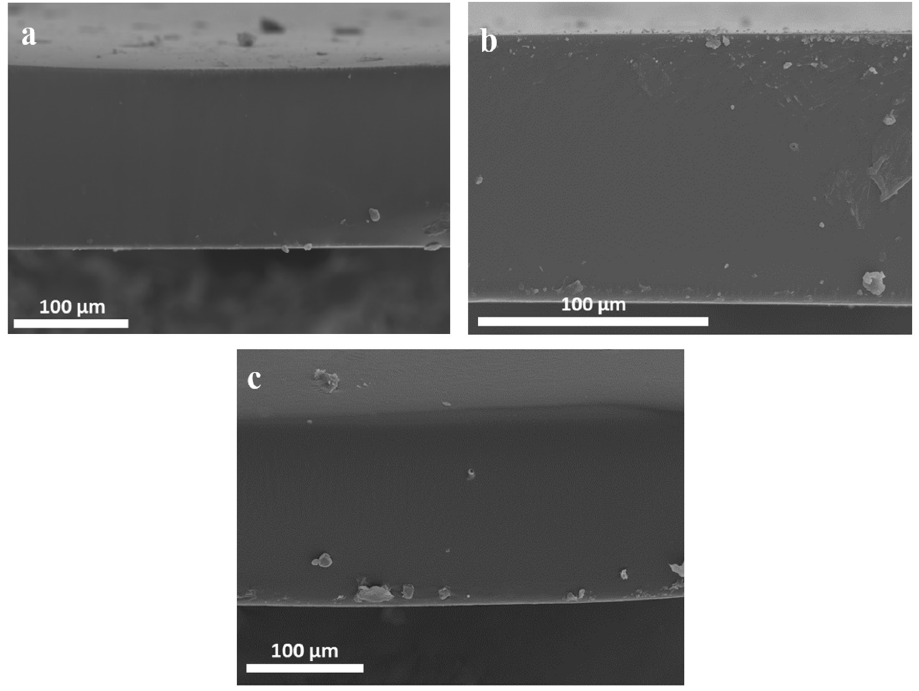
Figure 5. SEM micrographs of composite membranes containing 40 wt%. ( a ) [EMIM][TFSI], ( b ) [EMIM][C(CN) 3 ] and ( c ) [HMIM][TFSI]. 3.2. Gas Separation Properties of Polymer-IL Composite Membranes The gas separation properties of the 2,6Py-PEO 350 precursor copolymer and the com- posite membranes were determined using the Wicke–Kallenbach method at 30 °C. The gas permeability data (CO 2 , CH 4 , H 2 ) are shown in Table 1. It was observed that the pre- cursor copolymer exhibits much lower gas permeability than composite membranes con- taining the imidazolium-based ILs with TFSI - (IL1 and IL3). Generally, IL molecules plas- ticize the polymer matrix, leading to improved chain mobility and increased free volume, and consequently to enhanced gas diffusivity and permeability [18,41–44]. However, sol- ubility also plays a significant role in permeability according to the solubility-diffusion mechanism for dense membranes [45]. For instance, ILs with TFSI - and C(CN) 3- as counter anions are reported to show high CO 2 solubility due to chemical interactions of CO 2 mol- ecules with the anions [46–48]. In addition, the higher fractional free volume of ILs com- pared to polymers facilitates the CO 2 diffusion across composite membranes [38]. In con- trast to this, CH 4 and H 2 have no significant interactions with ILs [38], thus very small additional solubility contribution is expected for CH 4 and H 2 in composite membranes, and, therefore, diffusion mainly contributes to CH 4 and H 2 permeability increases. As a result, the permeability increment is more significant for CO 2 instead of H 2 and CH 4 due to the high diffusivity and solubility of CO 2 in a polymer and IL matrix, respectively. For this reason, CO 2 /CH 4 and CO 2 /H 2 ideal selectivities are also increased with the addition of ILs. In contrast, the incorporation of the imidazolium-based IL with C(CN) 3- (IL2) into the polymer matrix caused a clear reduction of CH 4 and H 2 permeability, while CO 2 permea- bility was almost not affected. The reduction is more pronounced for H 2 than CH 4 . This phenomenon could be possibly attributed to two reasons. The lower molar volume of the C(CN) 3- counter anion enables IL accommodation in the initial available free interchain spacing, thus restricting chain mobility and resulting in smaller interchain spacing for gas transport. Another reason could be the strong interactions of the IL cation with the C(CN) 3-